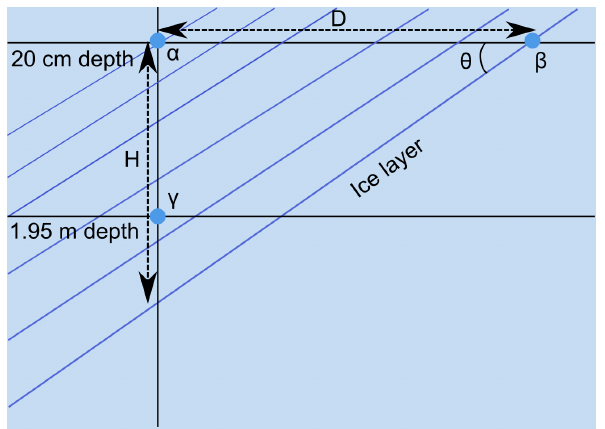
Figure 8. Schematic illustration for the mathematical relation be- tween ice ages.